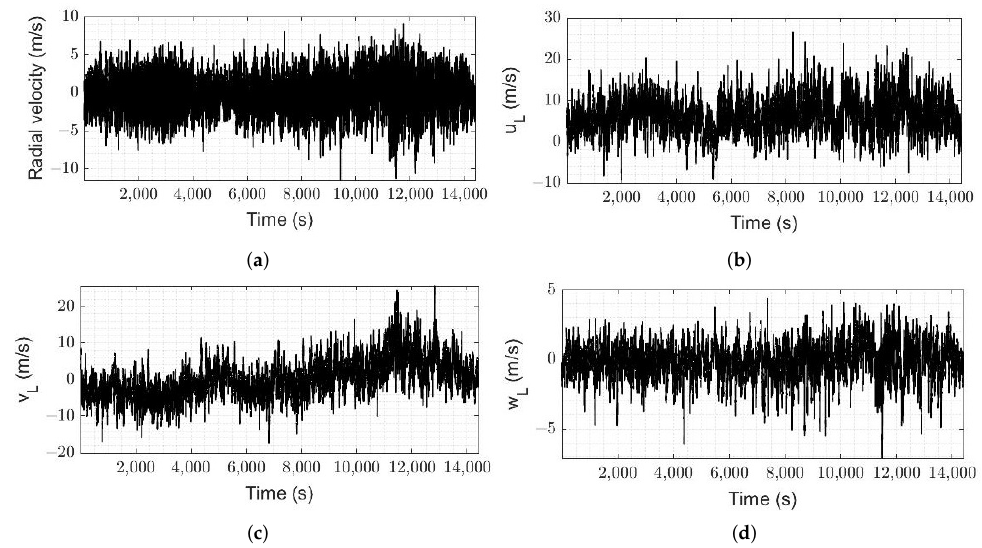
Figure 3. An example of time series of radial velocity at 60m AGL ( a ) and derived wind vector components: u L ( b ), v L ( c ) and w L ( d ), with corresponding mean values equal to (6.40 ± 4.00)m/s, ( − 0.41 ± 4.86)m/s and ( − 0.19 ± 1.26)m/s, for a four-hour period at 3 December